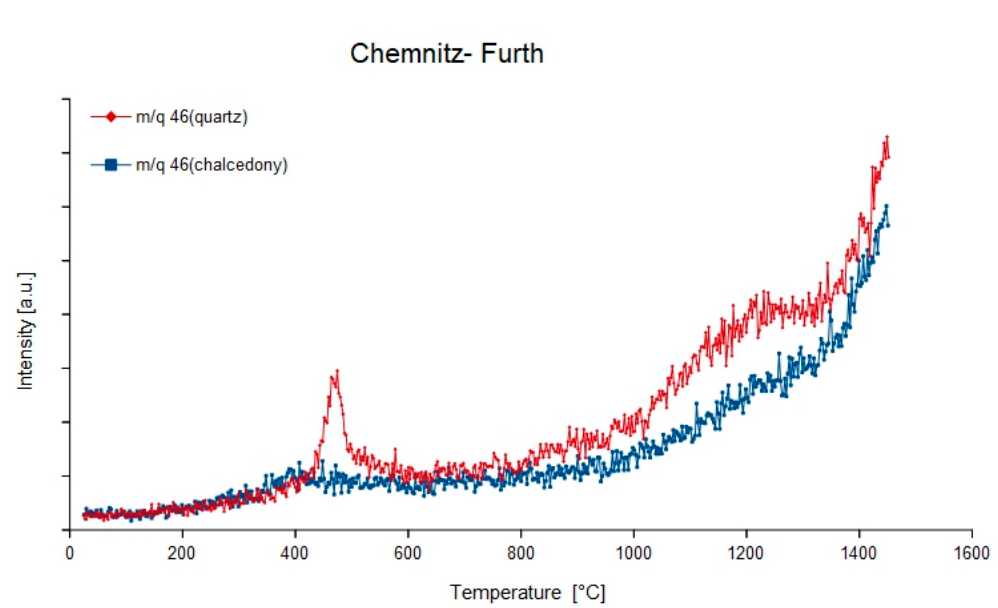
Figure 8. Degassing curves of the mass-charge ratio 46 ( 14 N 16 O 2 ) of quartz and chalcedony in the agate sample from Chemnitz- Furth, Germany.